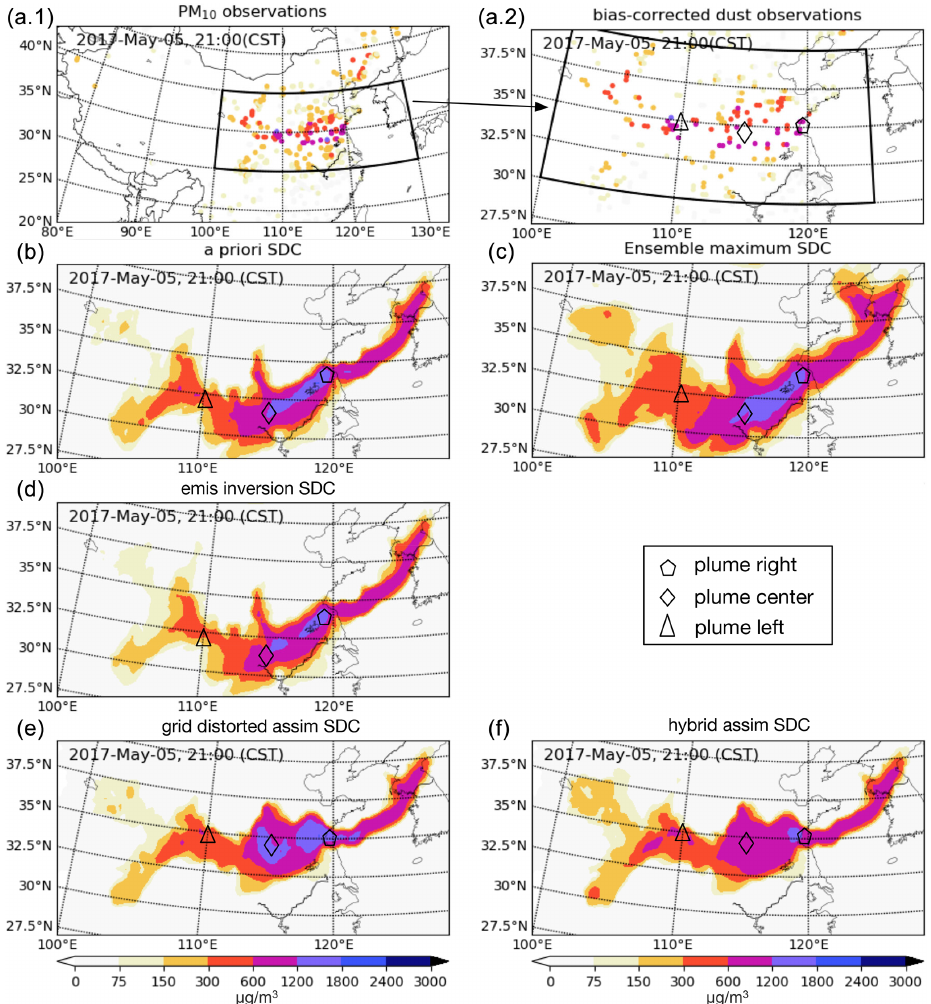
Figure 7. PM 10 (a.1) , bias-corrected dust observations (a.2) , the a priori forecast (b) , ensemble maximum (c) dust forecast and dust forecast driven by emis inversion posterior (d) , the grid-distorted assim posterior (e) , and hybrid assim posterior simulation (f) at 21:00CST on 5 May. SDC: surface dust